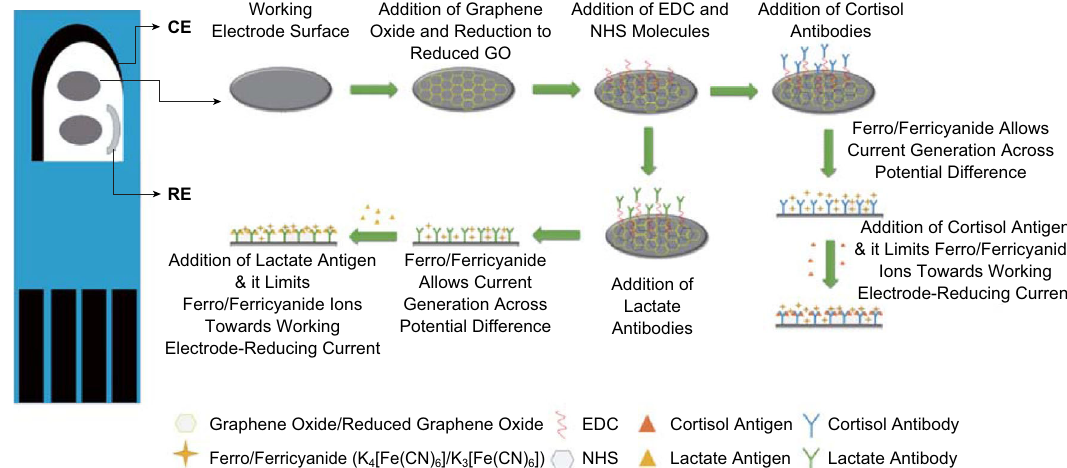
Fig. 2 Schematic illustration of carbon screen-printed electrode: CE counter electrode, RE reference electrode. Working electrode surface is with sequence of surface modifications for bioassay fabrication. The e-RGO (electroreduced graphene oxide)-modified SPEs were then functionalized with cortisol and lactate antibodies to develop a biointerface for label-free electrochemical